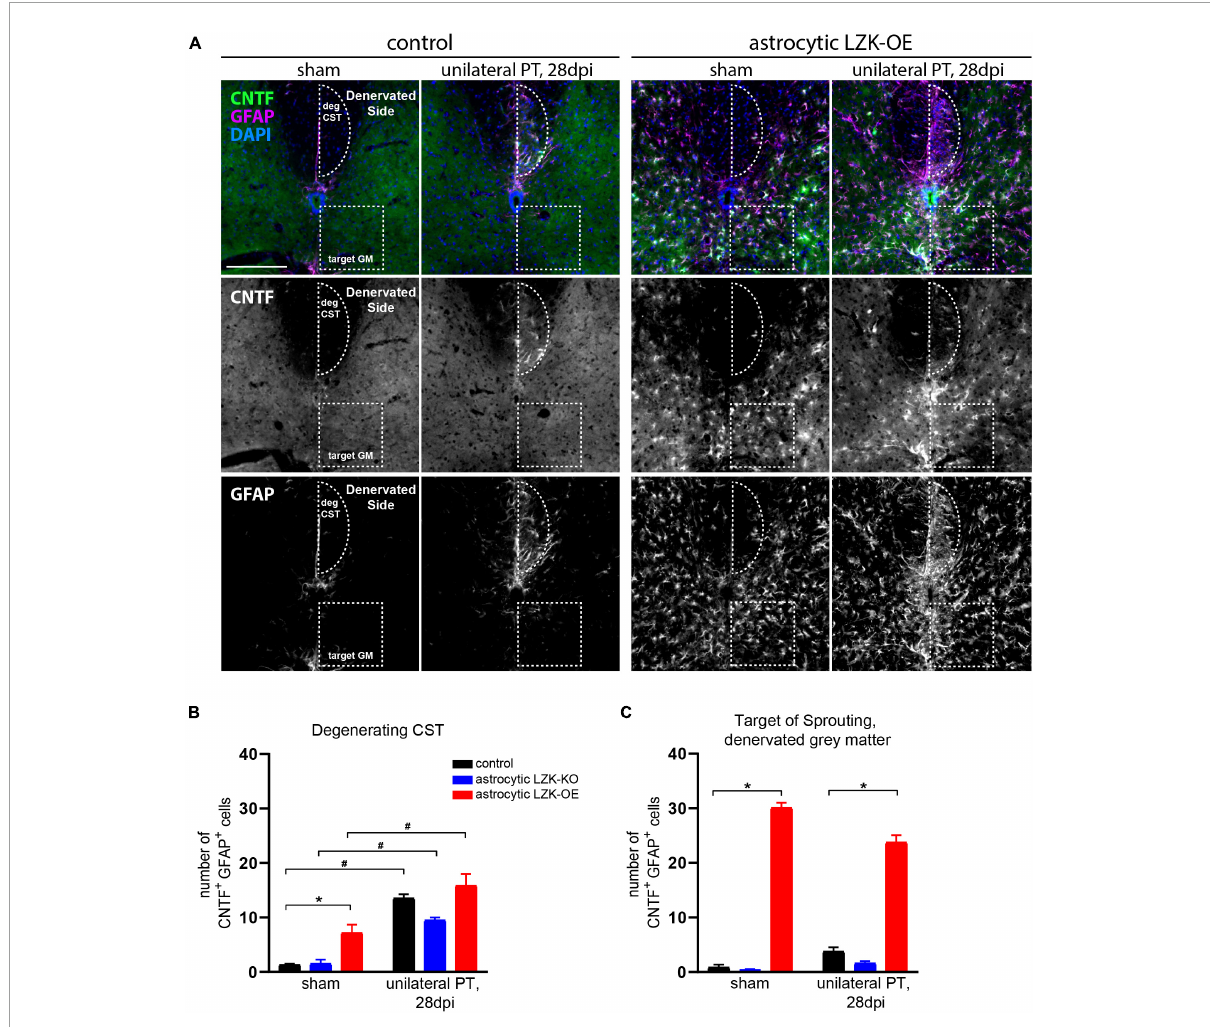
FIGURE5 Upregulation of astrocyte-derived CNTF following astrocytic LZK overexpression. (A) Immunofluorescence staining of CNTF and GFAP in the indicated tamoxifen treated groups, with no injury or 28 days after unilateral PT. Dotted semi-oval outlines the degenerating hemi-CST (labeled as “deg CST”) at the cervical spinal cord; dotted box outlines the gray matter in the denervated spinal cord that intact CST axons sprout into (labeled as “target GM,” on the “Denervated Side”). Scale bar represents 200 µ m. (B) Quantification of the number of CNTF + GFAP + cells in the degenerating CST [outlined by dotted semi-oval in panel (A) ], in the groups indicated, with no injury or 28 days after unilateral PT. n = 3 per group; graphing group mean with SEM. By two-way ANOVA, p < 0.05 for main injury effect and genotype effect, no interaction. In the sham injury group, asterisk (*) indicates p < 0.05 for post-hoc comparison between genotype control and GFAP-CreER T2 ; LZK OE mice with Bonferroni correction. Pound sign (#) indicates p < 0.05 between sham and 28 dpi within each genotype by post-hoc comparisons with Bonferroni correction. Not marked on graph: p < 0.05 between astrocytic LZK-KO and LZK-OE mice without injury, by post-hoc comparison Bonferroni correction. (C) Quantification of the number of CNTF + GFAP + cells in the sprouting target gray matter [outlined by dotted box in panel (A) ], in the groups indicated, with no injury or 28 days after unilateral PT. n = 3 per group; graphing group mean with SEM. By two-way ANOVA, p < 0.05 for main genotype effect only. Asterisk (*) indicates p < 0.05 for post-hoc comparison between genotype control and GFAP-CreER T2 ; LZK OE mice at the corresponding timepoint with Bonferroni correction. Not marked on graph: p < 0.05 between astrocytic LZK-KO and LZK-OE mice without injury or on 28 dpi, by post-hoc comparison Bonferroni